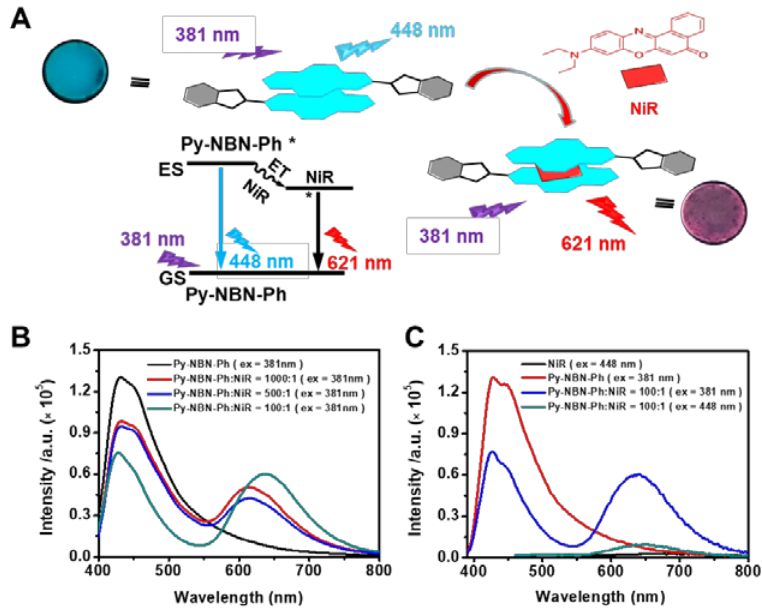
Figure 6. Artificial light-harvesting application of Py-NBN-Ph. ( A ) Schematic diagram of light-harvesting application, Py-NBN-Ph is the ground state molecule and Py-NBN-Ph* is the excited state molecule; ( B ) Emission spectra of light-harvesting films with different Py-NBN-Ph/NiR ratios; ( C ) Emission spectra of NiR, Py-NBN-Ph and Py-NBN-Ph/NiR (100:1).